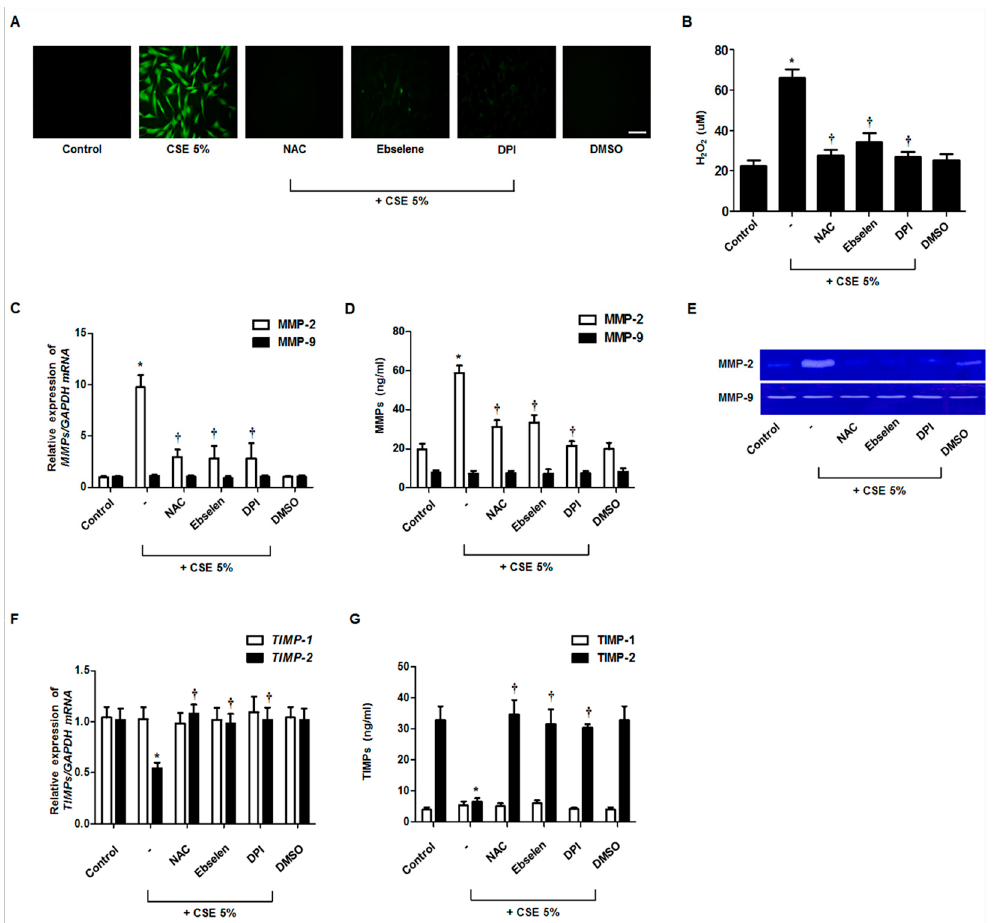
Figure 2. E ff ects of ROS on CSE-regulated MMP and TIMP expression in nasal fibroblasts. Total ROS and mitochondrial superoxides were quantified using the 2,7-dichlorofluorescein diacetate assay and Amplex Red assay ( A , B ). Fibroblasts were pretreated with NAC (1 mM), ebselen (10 µ M), and DPI (2 µ M) before being treated with CSE (5%). The expression levels of MMP and TIMP mRNAs were determined by real-time PCR ( C , F ). MMP and TIMP protein levels were determined using ELISA ( D , G ). The enzymatic activities of MMP-2 and MMP-9 were measured by gelatin zymography ( E ). * p < 0.05 vs. control; † p < 0.05 vs. CSE only. Scale bar = 50 µ